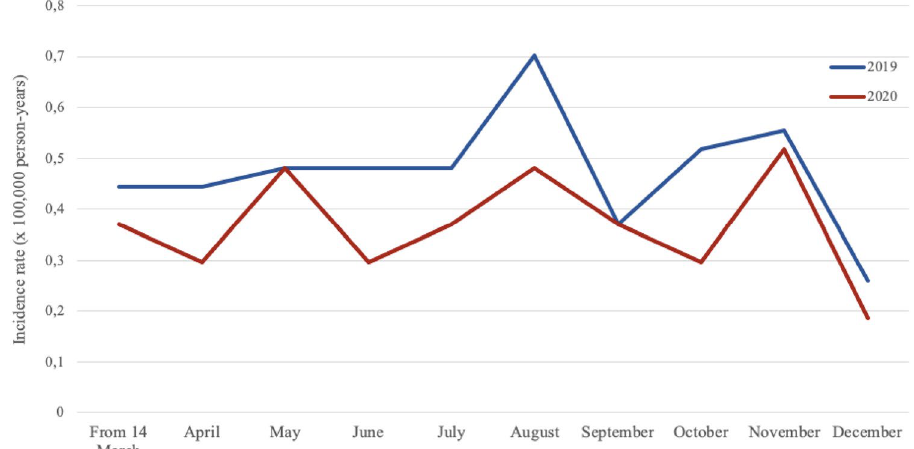
Figure 1. Incidence rate of FEP per month during the COVID-19 pandemic (2020) and the equivalent period in prior year (2019).